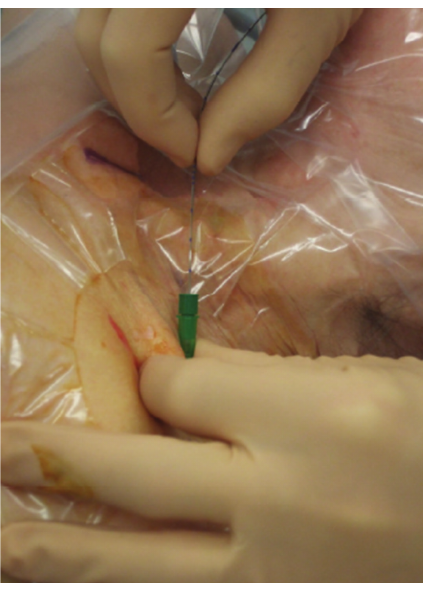
Figure 4: Catheter insertion through the cannula. Catheter is advanced up to 5cm over the cannula tip.